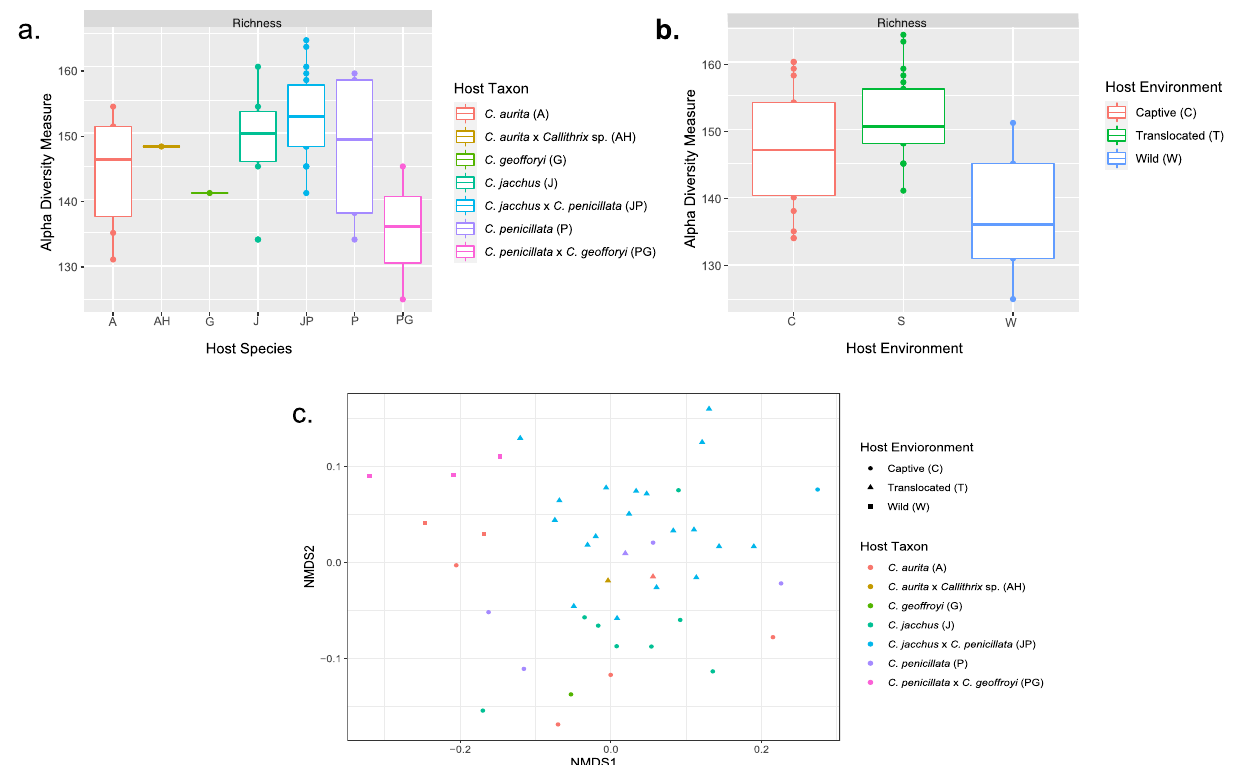
Figure 4. Boxplots of gut microbiome predicted gut KEGG pathways richness by host taxon ( a ) and host environment ( b ). Panel ( c ) shows a NMDS ordination plot for gut microbiome predicted gut KEGG pathways beta-diversity measured by the Bray–Curtis dissimilarity index. Legend of host classifications are shown on the right side of each plot.